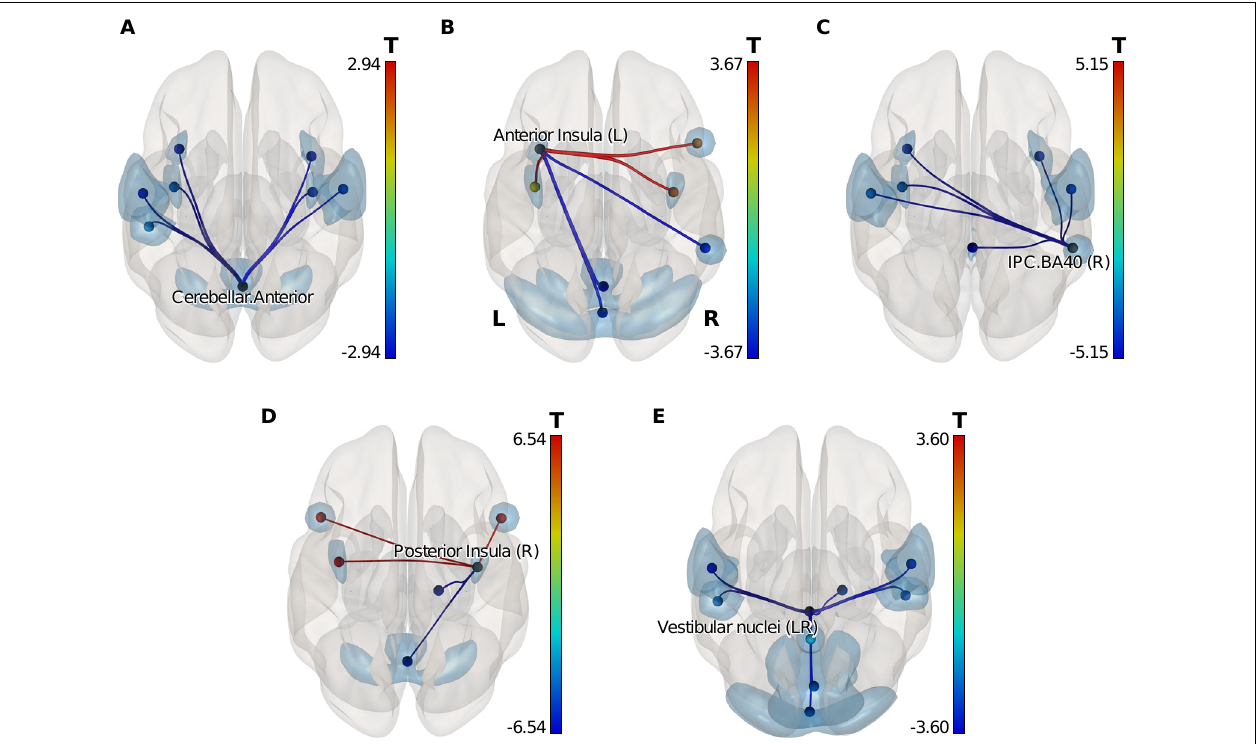
FIGURE 5 | ROI-level networks showing significant PPI connectivity modifications in the NBS analysis post-flight vs. pre-flight, cosmonauts vs. controls for the following regions: (A) the anterior part of the cerebellar network (Conn Networks atlas); (B) the left anterior insula; (C) the right inferior parietal cortex, BA40; (D) the right posterior insula; (E) the vestibular nuclei. The network-defining threshold (connection-wise) was set to p < 0.05, and the ROI-level results were FDR-corrected for multiple comparisons (NBS by intensity, q < 0.05, p < 0.05 at the ROI level). Line color indicates the sign and magnitude of the effect for individual connections comprising the networks. Note that due to the nature of the NBS analysis, no individual connection contributing to the significantly changed network may be considered as significantly altered on its own. Cyan blobs indicate the location of the ROIs for the illustrative purposes.